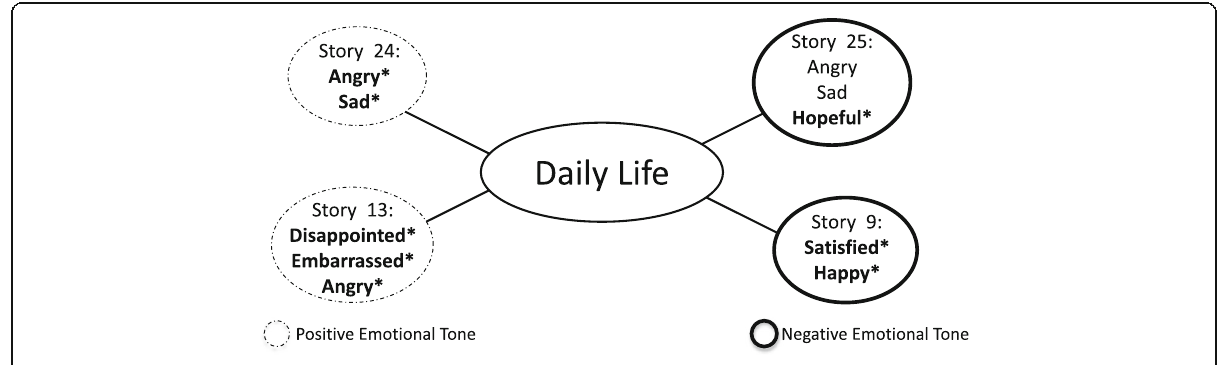
Fig. 4 Paradoxical experiences related to daily